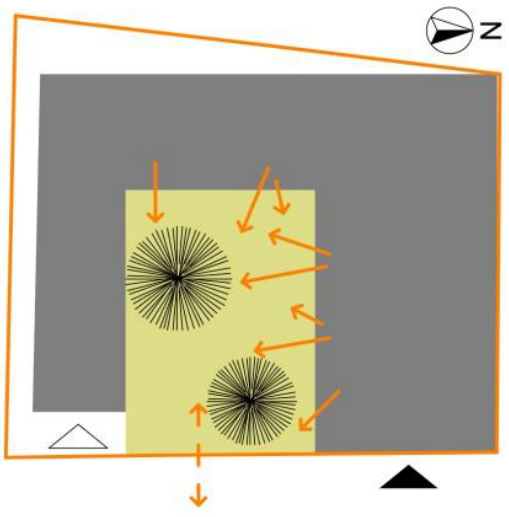
Figure 6. The U-shaped plan of the Reinanzaka house and openings towards the garden.